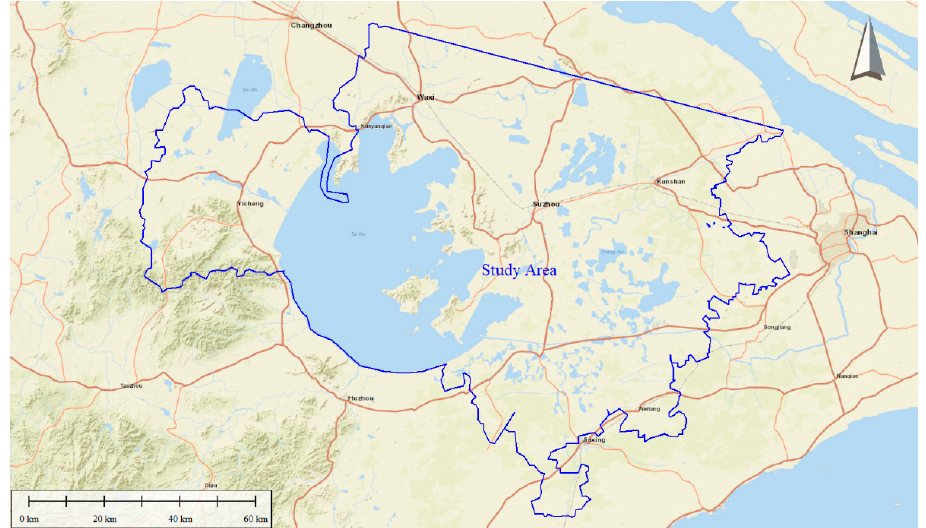
Figure 1. Geographical location map of the study area.